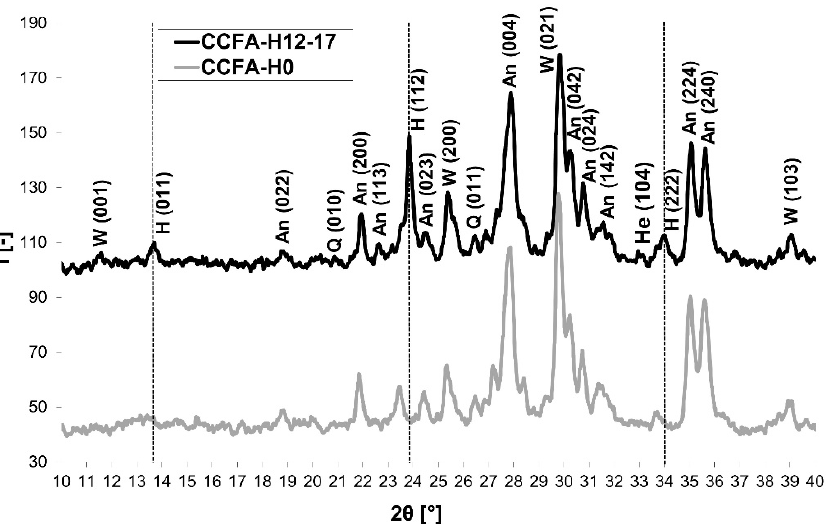
Figure 4. The comparison of the mineralogical composition (XRD patterns) of fired bodies: CCFA-H0 vs. CCFA-H12-17 with no sulfur dioxide content in the flue gas during firing (W: Wollastonite,